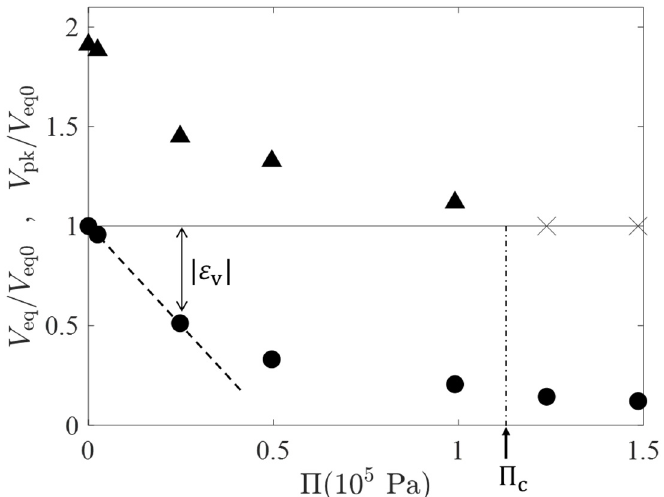
Figure 4. A plot of the osmotic pressure Π estimated by the van’t Hoff equation ( Π = RTC PEG ) versus the peak volume V pk (the filled triangles) during the temporal swelling and the equilibrium volume V eq (filled circles) normalized by V eq 0 , the equilibrium gel volume for Π = 0. The cross marks in the horizontal line of a height of unity represent that the volume peak was not observed at the Π values.